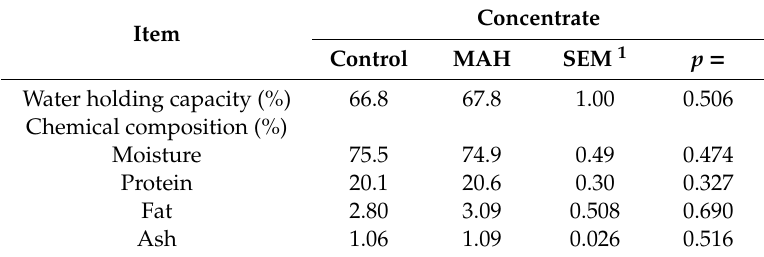
Table 3. Water holding capacity and chemical composition of the Longissimus muscle of growing lambs fed barley straw and concentrate containing sunflower meal and seed either untreated (control) or treated with malic acid and heat (MAH). Concentrate Item Control MAH SEM 1 p = Water holding capacity (%)